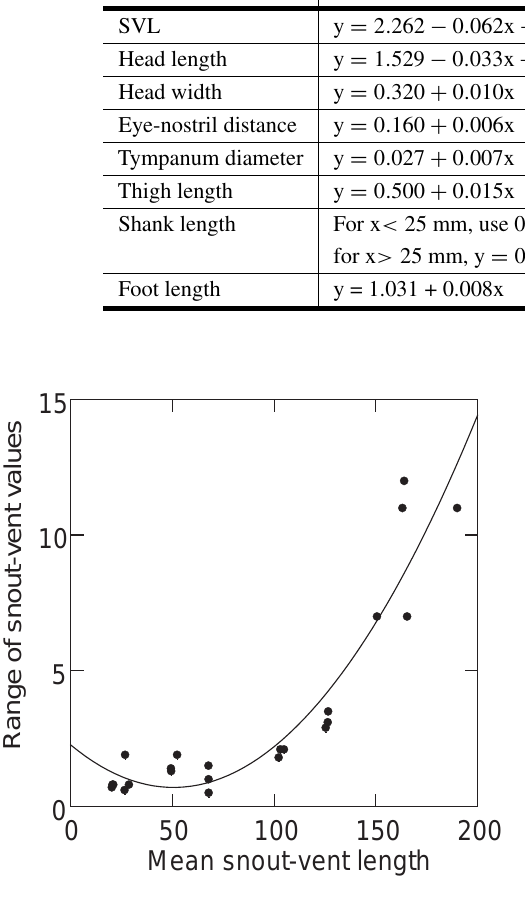
Fig. 3 – Measurement error data for SVL with quadratic smoother. All values in